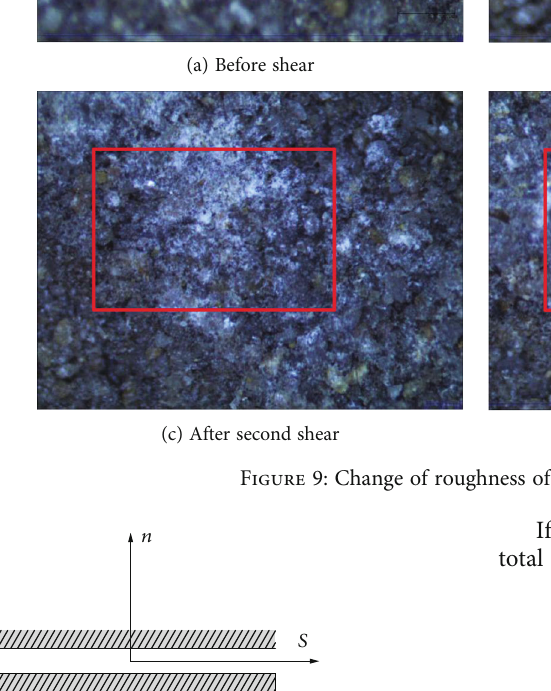
Figure 10: Coordinate system of the structural